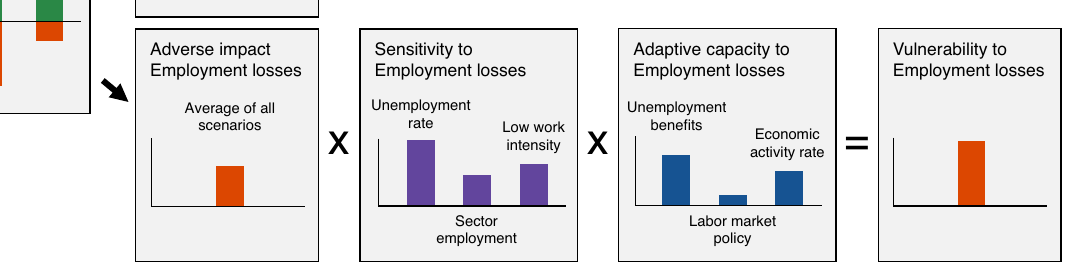
Fig. 7 | Concept overview of the bene fi t-vulnerability calculation. Regional impacts are distinguished between bene fi ts and adverse impacts by comparing impacts of each scenario with impacts of the frozen scenario that represents the current electricity system. Regionalbene fi t of eachregion is computed with Eq.(1)